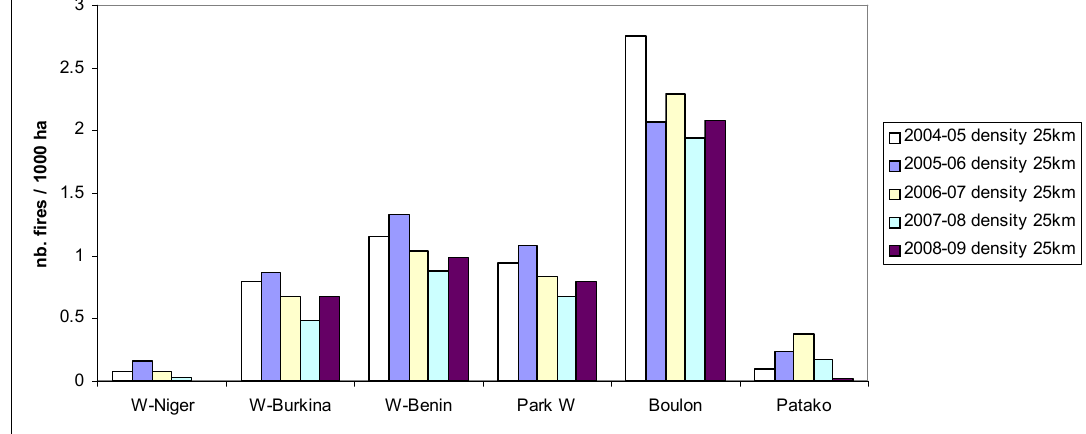
Figure 6. Fire density (nb. fire events/1,000 ha) inside the SUN test sites (a), in their 25 km buffer zone (b) and in the regional windows (c) from 2004 to 2009. Fire density at the end of the burning season in the SUN test sites